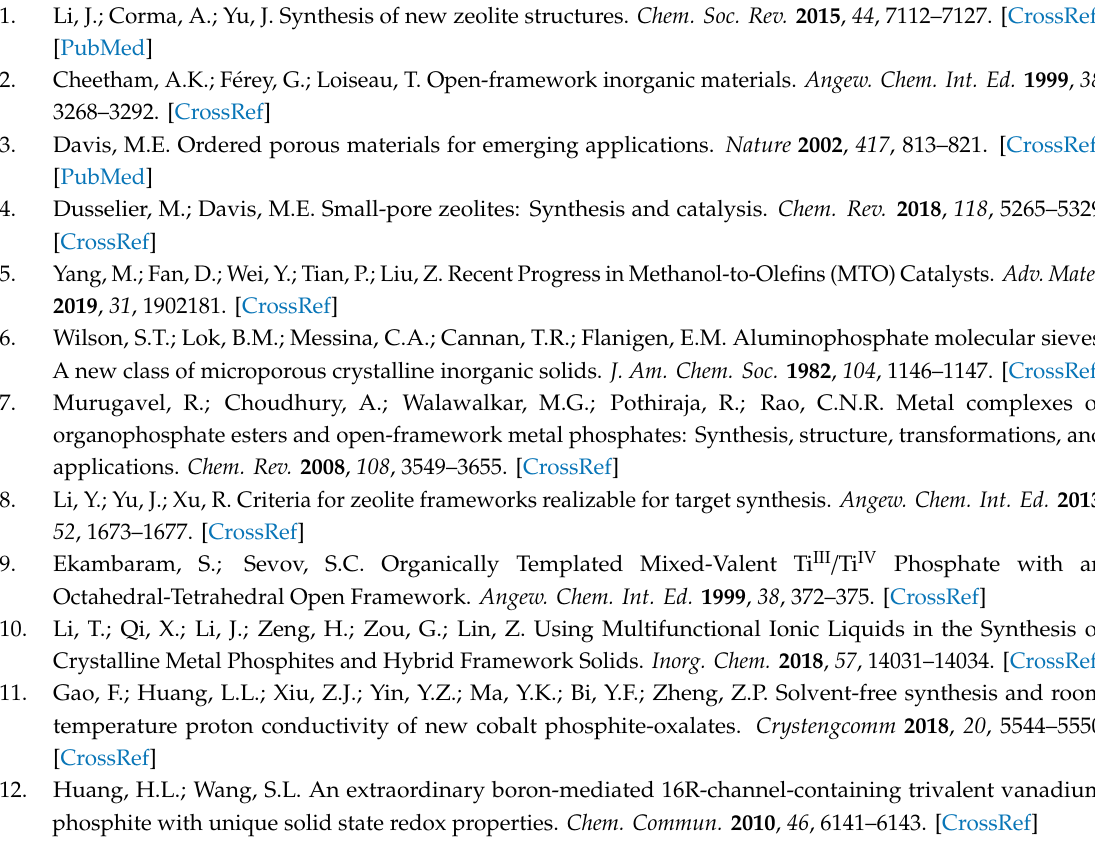
Table S1: Bond lengths [Å] and bond angles ( ◦ ) for compound